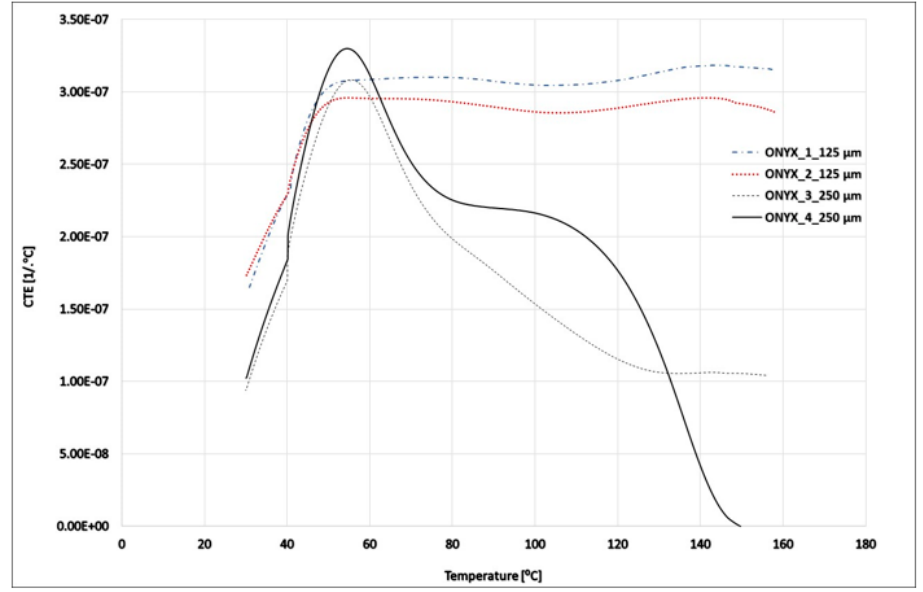
Figure 9. Thermomechanical analysis (TMA) curves showing the CTE the two series of ONYX material 3D printed using 125 µm and 250 µm layers.